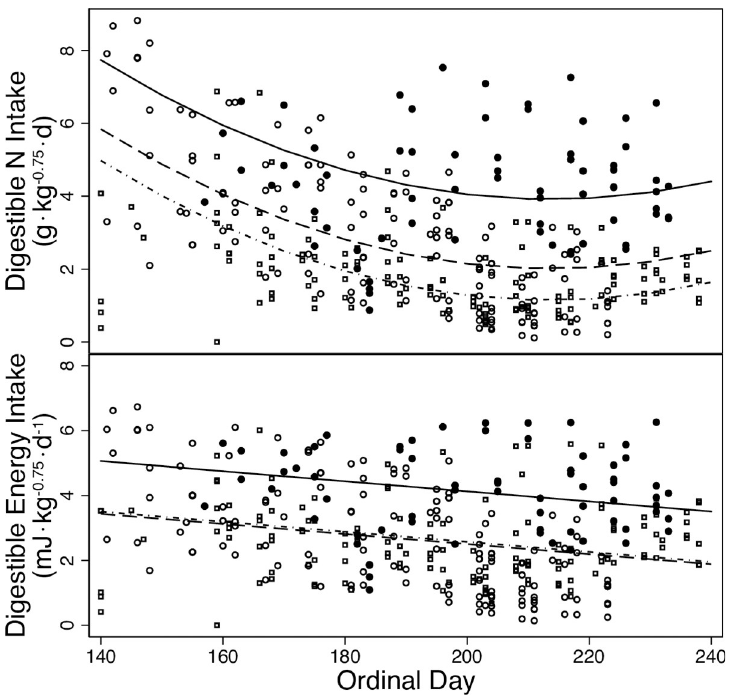
Fig 4. N and energy intakes. Daily intakes of digestible N (g•kg -0.75 •d -1 ; top panel) and digestible energy (MJ•kg -0.75 •d -1 ; top panel) of female moose in summer (May–August; ordinal day 140–240) at the Kenai Moose Research Center, Kenai Peninsula, Alaska, USA in 2014–2016. Symbols are observed data. Lines are predicted relationships from mixed model regressions of intake against time for each year. Key: 2014 –solid line and solid circle; 2015 –dashed line and hollow circle; 2016 –dash-dotted line and hollow square. The period of early lactation is from ordinal day 140 to 170.